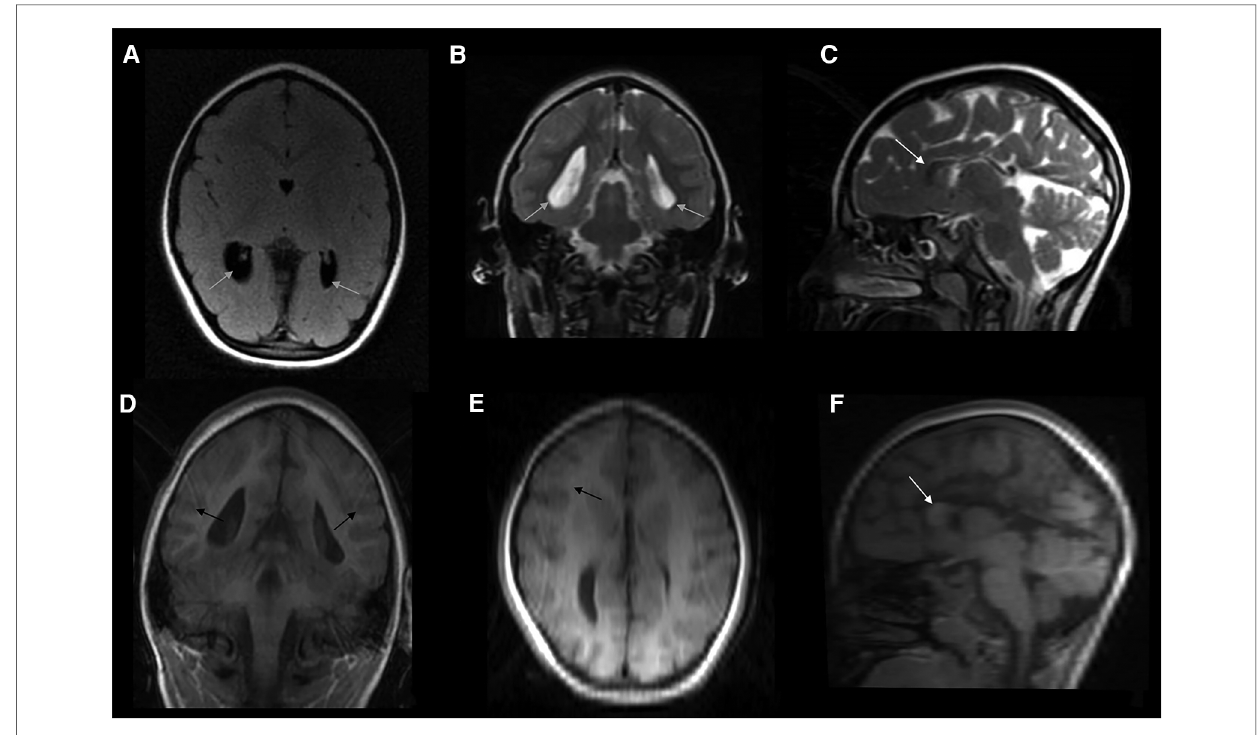
FIGURE 1 Composite panel of six neuroimages showing the brain MRI study in the girl, at the age of 3.5 years: FLAIR-axial scan ( A ), T2-weighted coronal ( B ), and sagittal ( C ) sections; and coronal T1 3D scan ( D ), as well as reconstructions (reformat) derived from this last study both in axial ( E ) and sagittal ( F ) planes. A complex picture of microcephaly, partial agenesis of the corpus callosum with remnants of the genu (white arrow), simpli fi ed gyral pattern especially in the parietal and occipital regions of both hemispheres; enlarged and fl attened ventricles (grey arrows), with colpocephaly and ectasia of temporal horns were also present. Apparently, no changes in myelin composition and cortical thickness were noticed (black arrows), even if the image protocol shown in this fi gure is of low quality due to partial panel reformatting. No signs or stigmata of TSC were detected within the brain (e.g., cortical